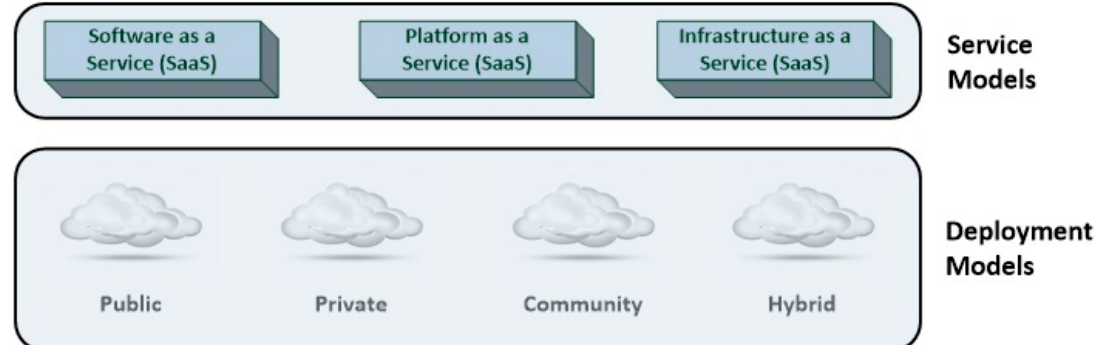
Figure 1. Cloud Computing Deployment and Service Models.